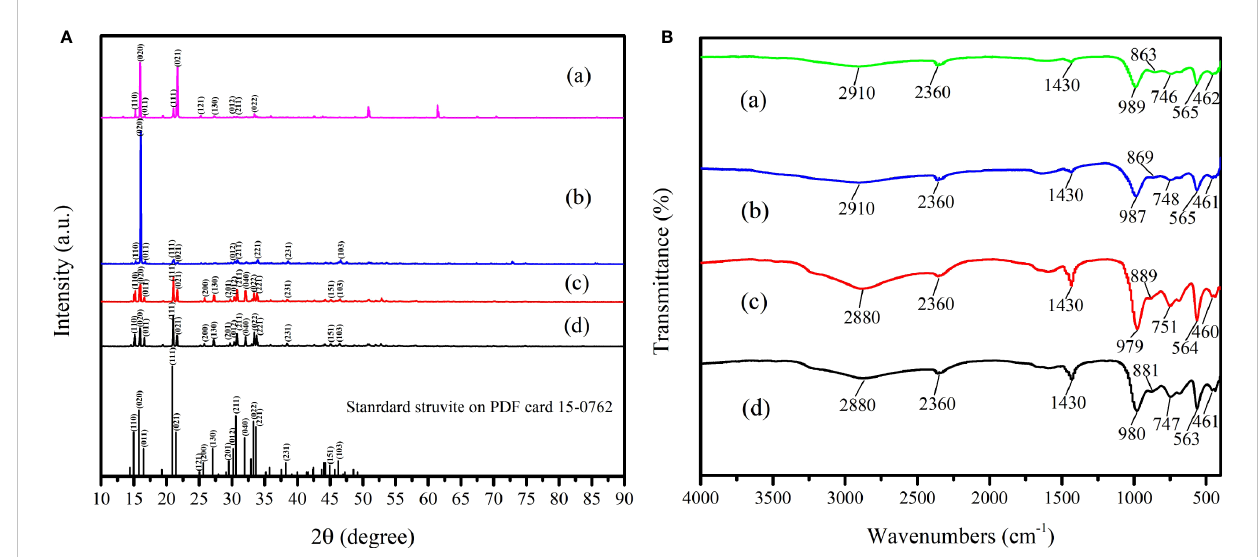
FIGURE 5 X-ray diffraction (XRD, A ) and Fourier-transform infrared microscopy (FTIR, B ) analysis of mineral crystals induced by bacterial strains in TSA medium, and ammonia solution in TSB medium. (a), the mineral crystals obtained in TSA medium with A. alteriprofundi HHU 13199 T ; (b), the mineral crystals obtained in TSA medium with A. alterisediminis N102 T ; (c), the mineral crystals obtained in TSB medium with ammonia; (d), the commercial struvite standard. Black bars show the struvite standard in PDF no. 15-0762.